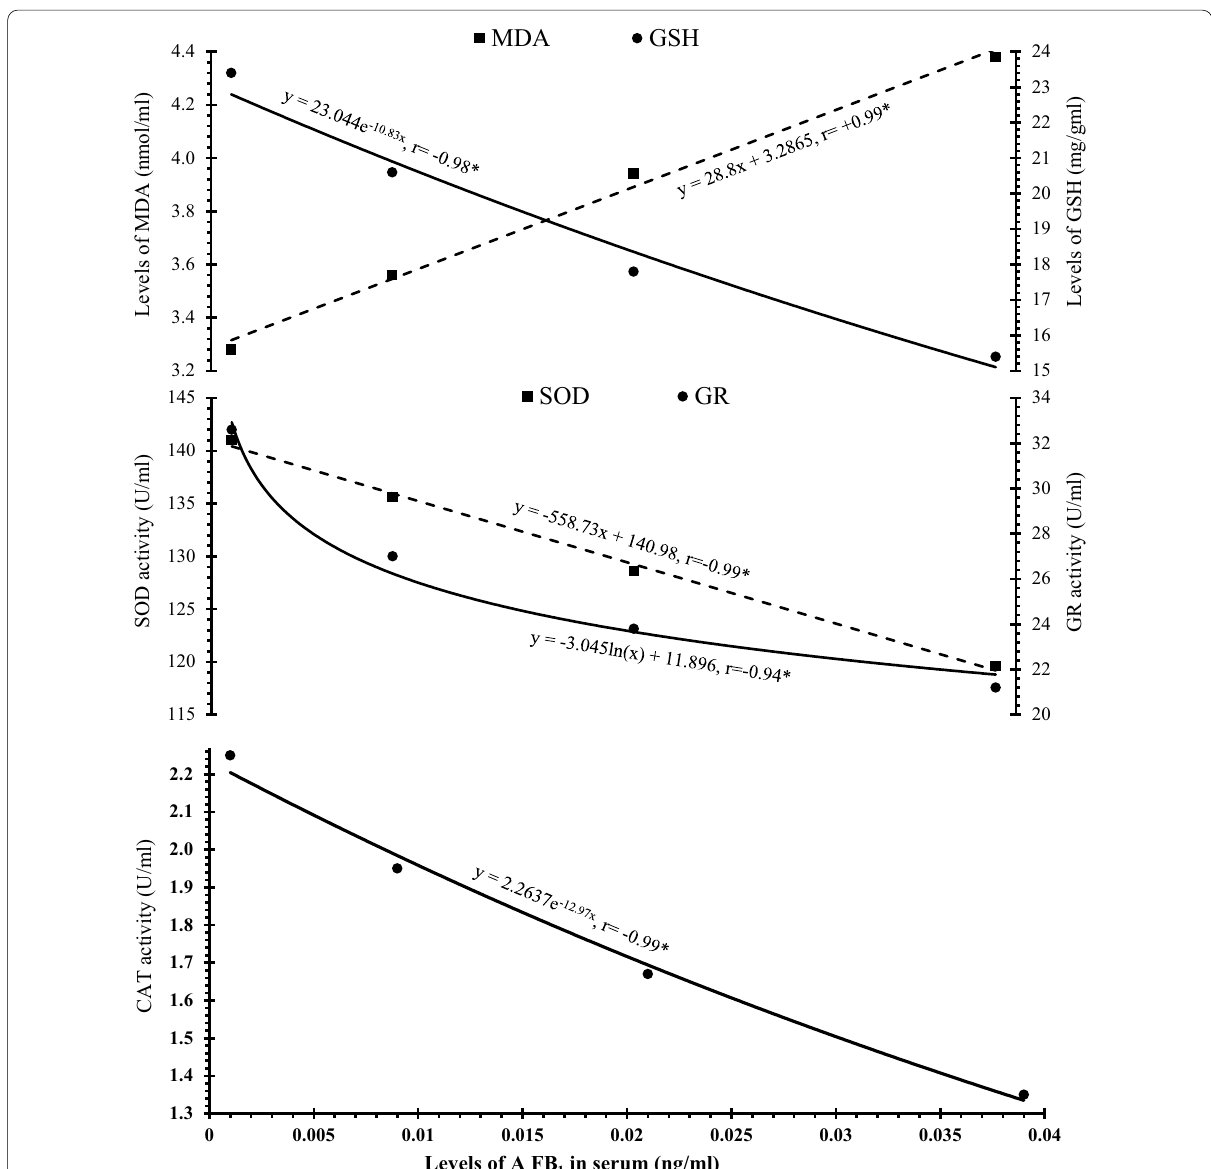
Fig. 1 The relationship between the levels of AFB 1 in the serum (ng/ml) of rats given a subacute dose of 7.49 mg of AFB 1 alone /kg every other day. x denotes serum AFB 1 levels, y denotes enzymes activity, and r * denotes a significant